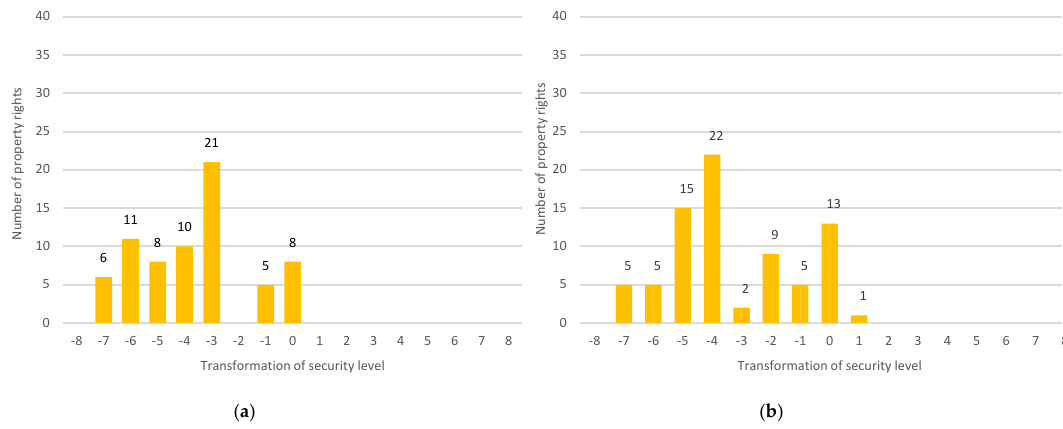
Figure 13. Transformation of the security level of property rights in MTB ( a ) cultivated and ( b ) residential lands.